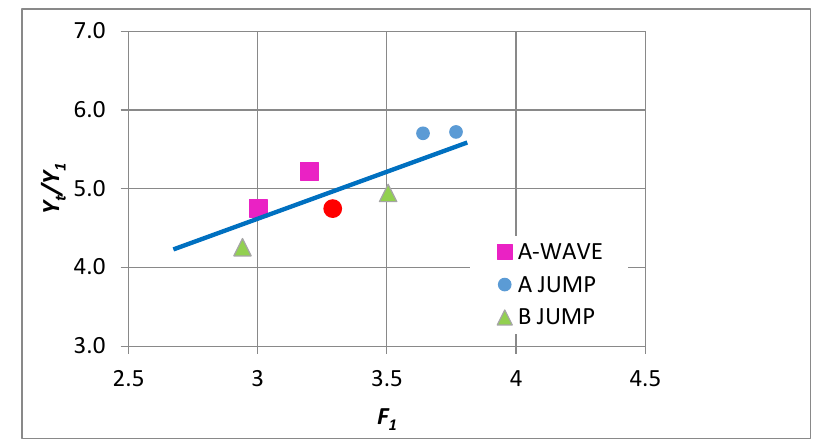
Figure 15. Regime chart for flow configurations with 0.6 < s/y 1 < 1.1. The dashed line shows the